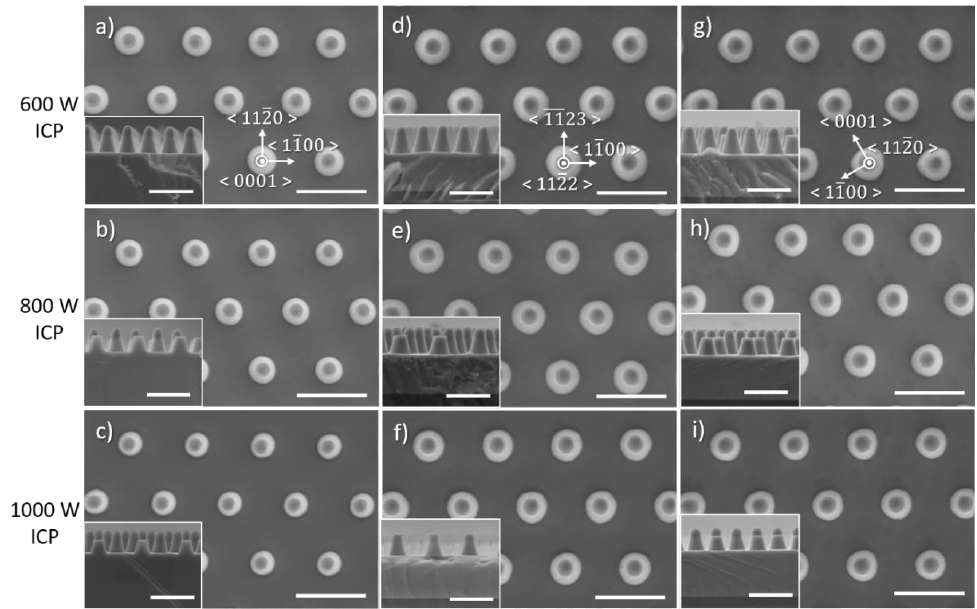
Figure 11. Plan view and cross-sectional (inset) SEM image of GaN nanorod etch series 6 with different inductively coupled plasma (ICP) power for ( a – c ) c -plane ( d – f ) (11 2̅2 ) semi-polar and ( g – i ) (11 2̅0 ) non-polar GaN layers. Scale bar is 1 µm.